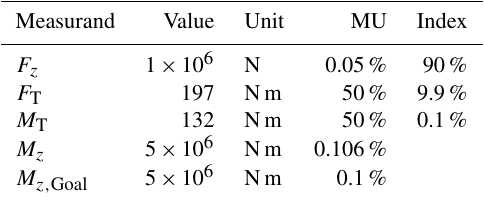
Table 1. Measurement uncertainty budget of the calibration torque moment M z in TSM without the F T and M T